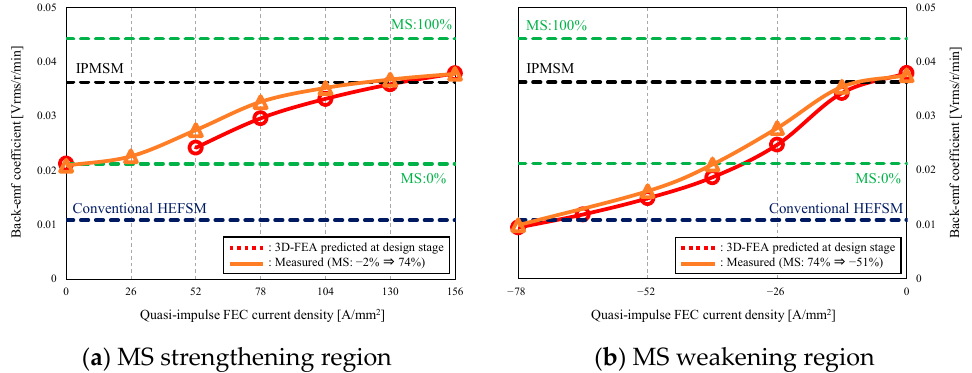
Figure 15. Measured back-emf coefficient curves and 3D-FEA predicted using JMAG-Designer ver. 20.0.01.